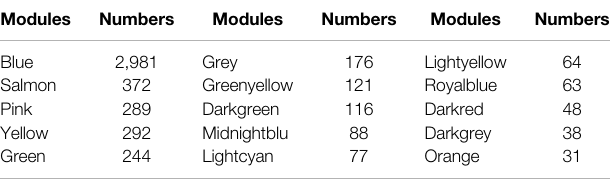
TABLE 1 | Number of genes contained in the merged module.